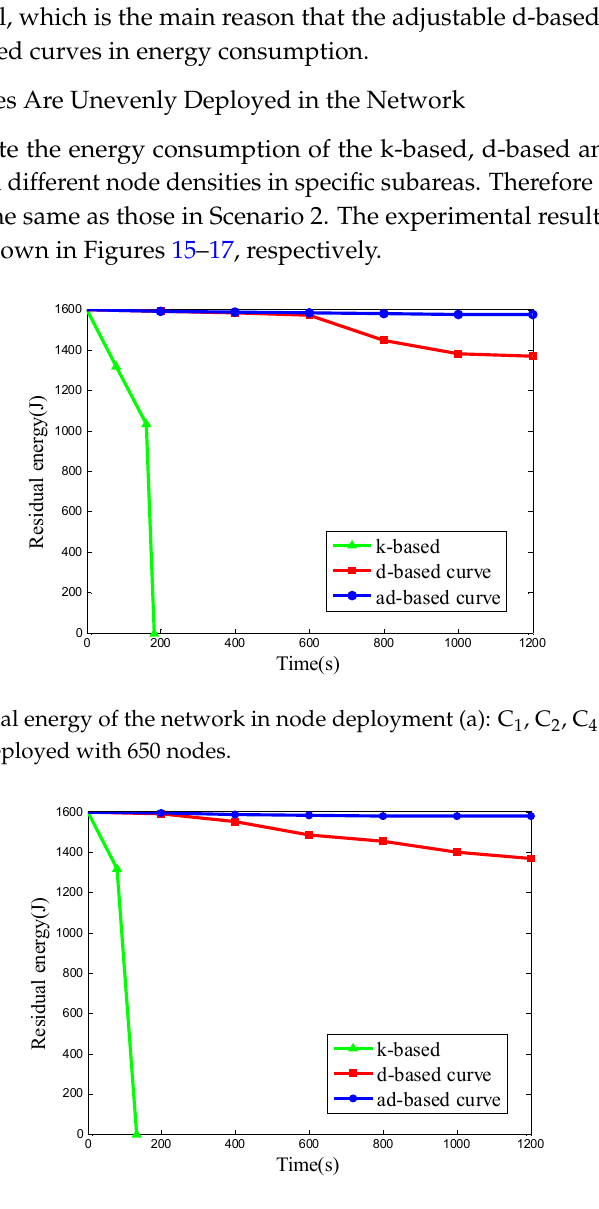
Figure 16. The residual energy of the network in node deployment (b): C 1 , C 3 are deployed with 50 nodes and C 2 , C 4 are deployed with 350 nodes.